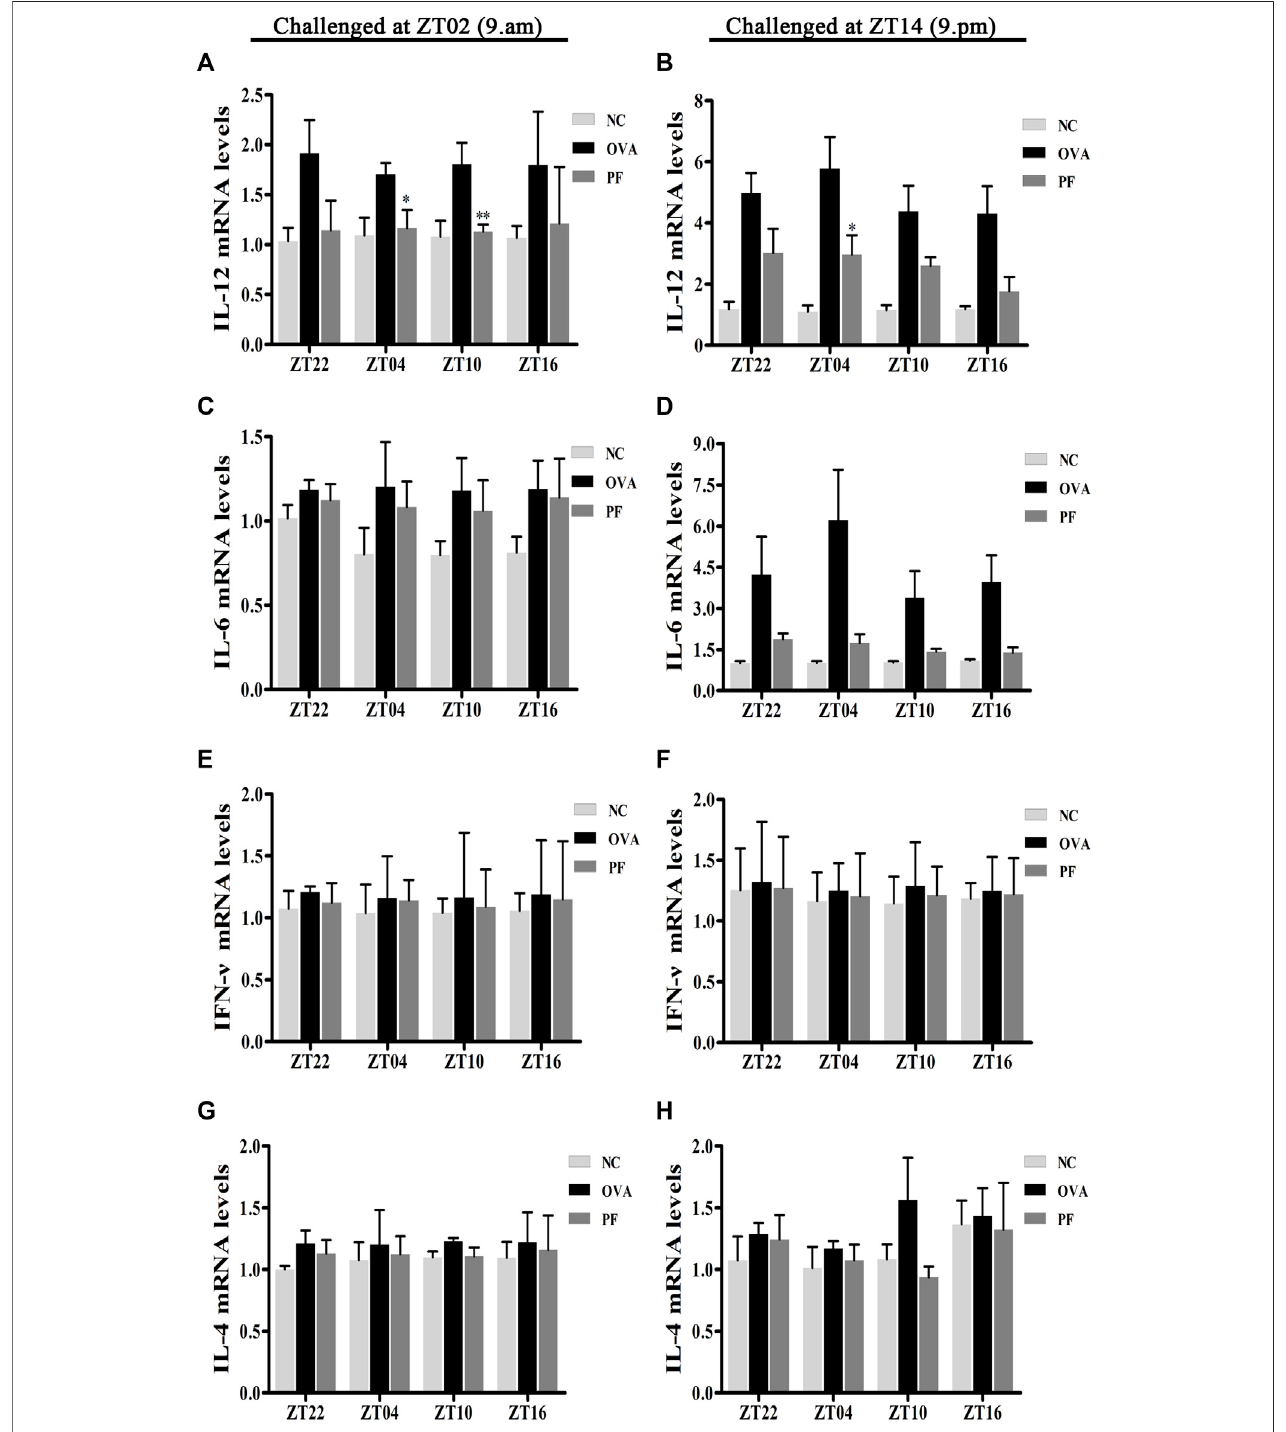
FIGURE7| Effect ofPFtreatment ontherelease ofin fl ammatorycytokinessuch as (A,B) interleukin (IL)-12, (C,D) IL-6, (E,F) interferon (IFN)- γ ,and (G,H) IL-4from theskintissuesofOVA/aluminiumhydroxide-challengedmice.PFreducedtheexpressionofIL-12mRNAatZT04andZT10.Dataareexpressedasmean ± SEM( n (cid:1) 6). * p < 0.05, ** p < 0.01 versus OVA mice at the same time points.